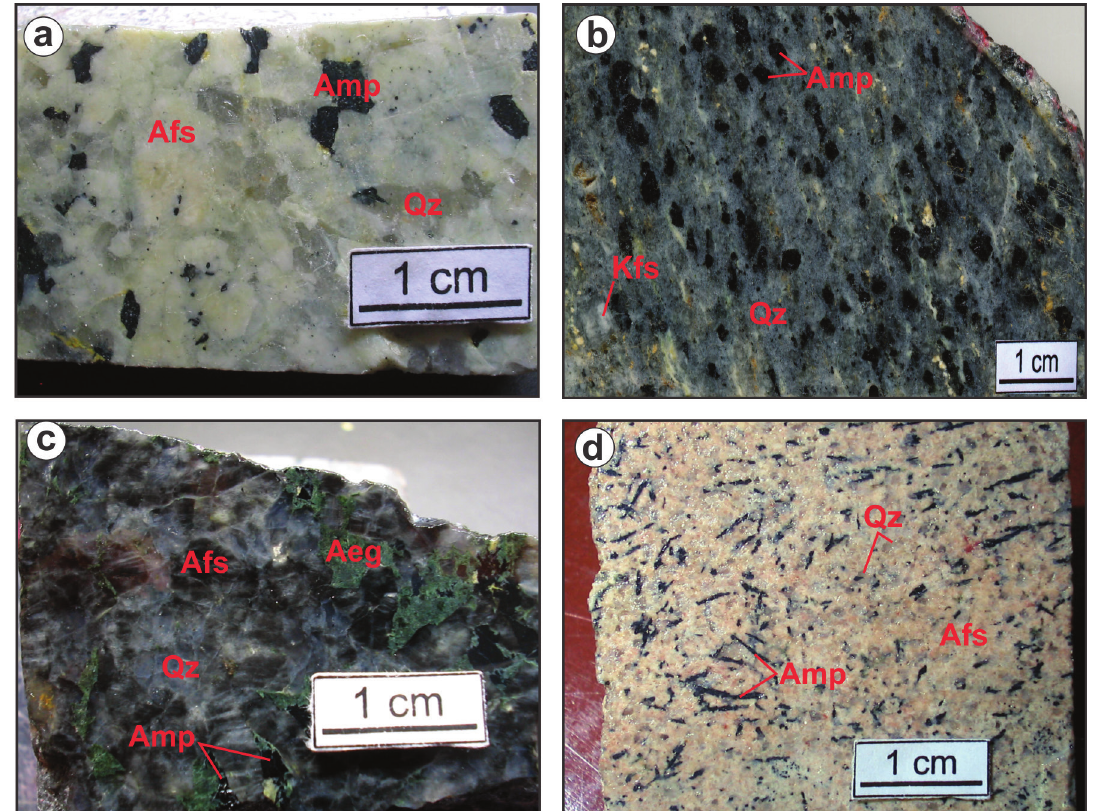
Figure 3 - Petrographic features of the Papanduva Pluton. (a) Macroscopic aspect of hololeucocratic alkali-feldspar granite of the massive facies. The medium-grained equigranular texture is defined by alkali feldspar (Afs), quartz (Qz) and sodic-calcic amphibole (Amp) as the main mafic phase. (b) Macroscopic aspect of alkali-feldspar granite of the deformed ‘protomylonitic’ facies, with elongated and rounded sodic amphibole megacrysts (Amp) in a fine-grained matrix made of quartz (Qz) and potassic feldspar (Kfs). (c) Macroscopic aspect of alkali feldspar granite of the deformed ‘cataclastic’ facies. The medium-grained equigranular texture is characterized by deformed quartz (Qz) and alkali feldspar (Afs) crystals and interstitial aegirine (Aeg) and sodic amphibole (Amp). (d) Macroscopic aspect of leucocratic alkali feldspar microgranite of the microgranitic facies, with magmatic flow texture defined by oriented prismatic sodic amphibole crystals (Amp) among alkali feldspar (Afs) and quartz